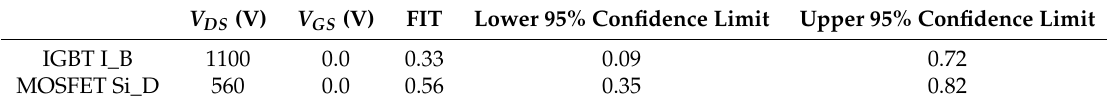
Table 3. Failure in time (FIT) at sea level of the MOSFET Si_D and IGBT I_B irradiated with fast